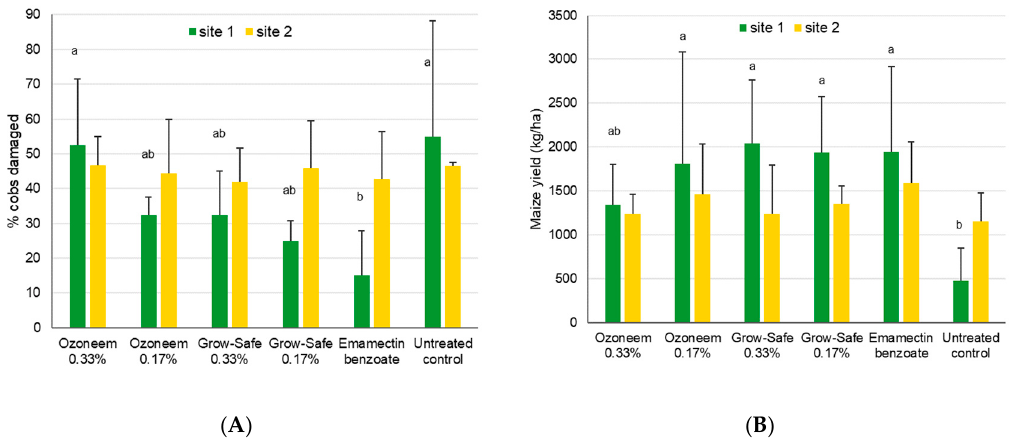
Figure 6. Mean maize cob damage induced by FAW + SD ( A ) and mean maize yields ( B ) after treatment with two neem-based products for site 1 near Wa, Upper West, Ghana, and site 2 near Accra, Ghana. Bars sharing the same letters are not significantly different from each other for the yield data, while missing letters indicate that no significant differences were found (i.e., for site 2).